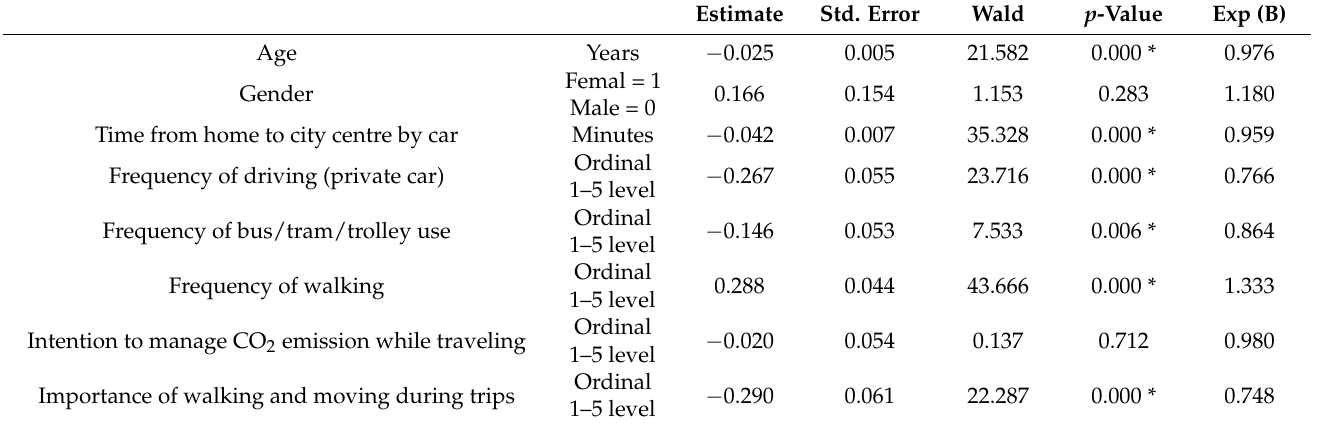
Table 9. Ordinal regression model for the frequency of TNC